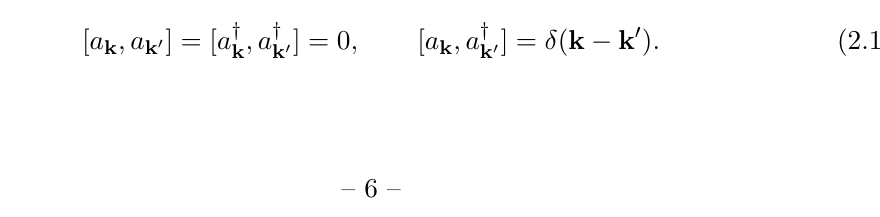
JHEP06(2020)084